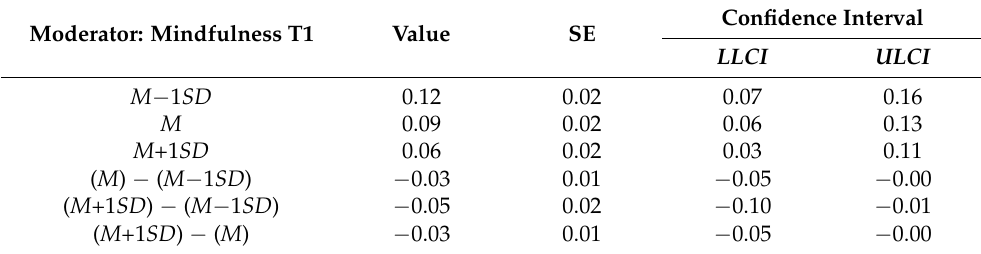
Table 4. Conditional Indirect Effect at Different Values of Mindfulness.